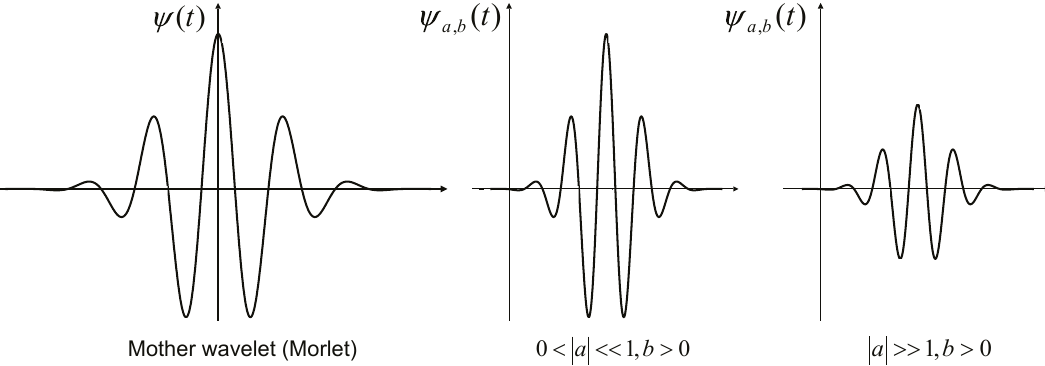
Figure 33. Qualitative representation of an example of the mother wavelet ( left ) and corresponding compressed ( middle ) and dilated versions of the mother wavelet ( right